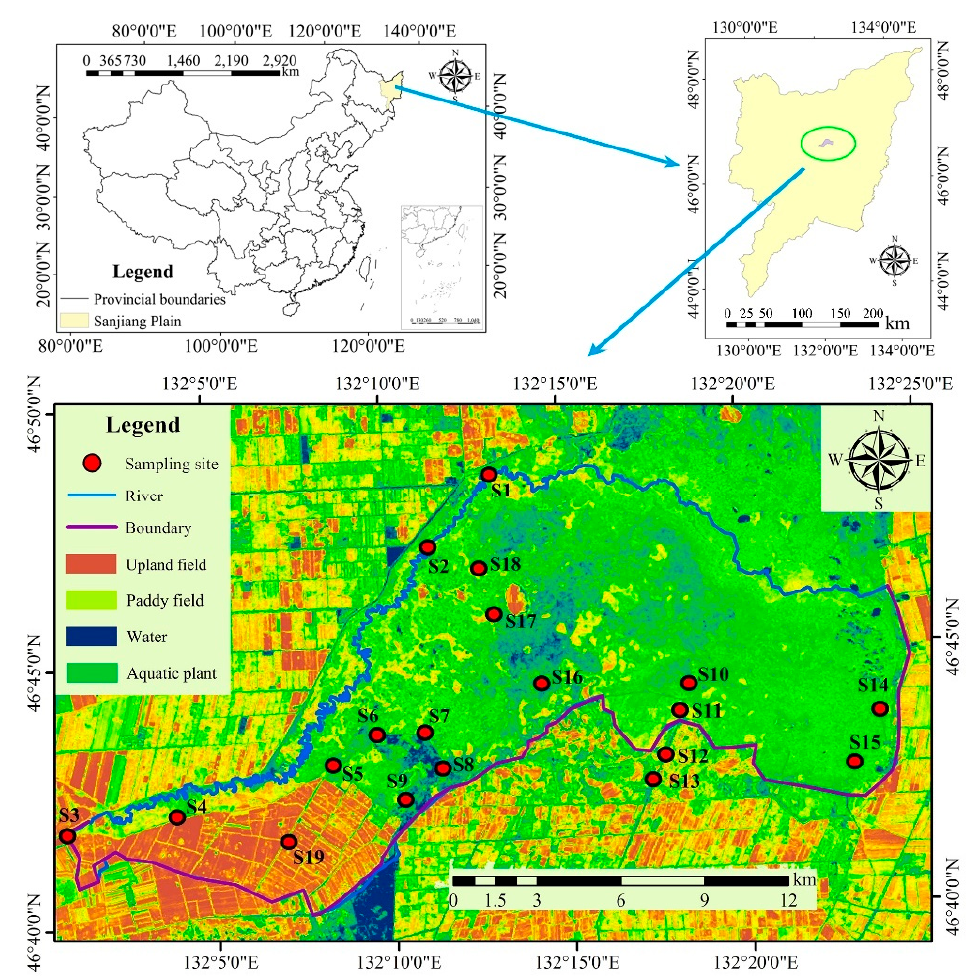
Figure 1. Locations of sampling sites in Qixing River wetland.